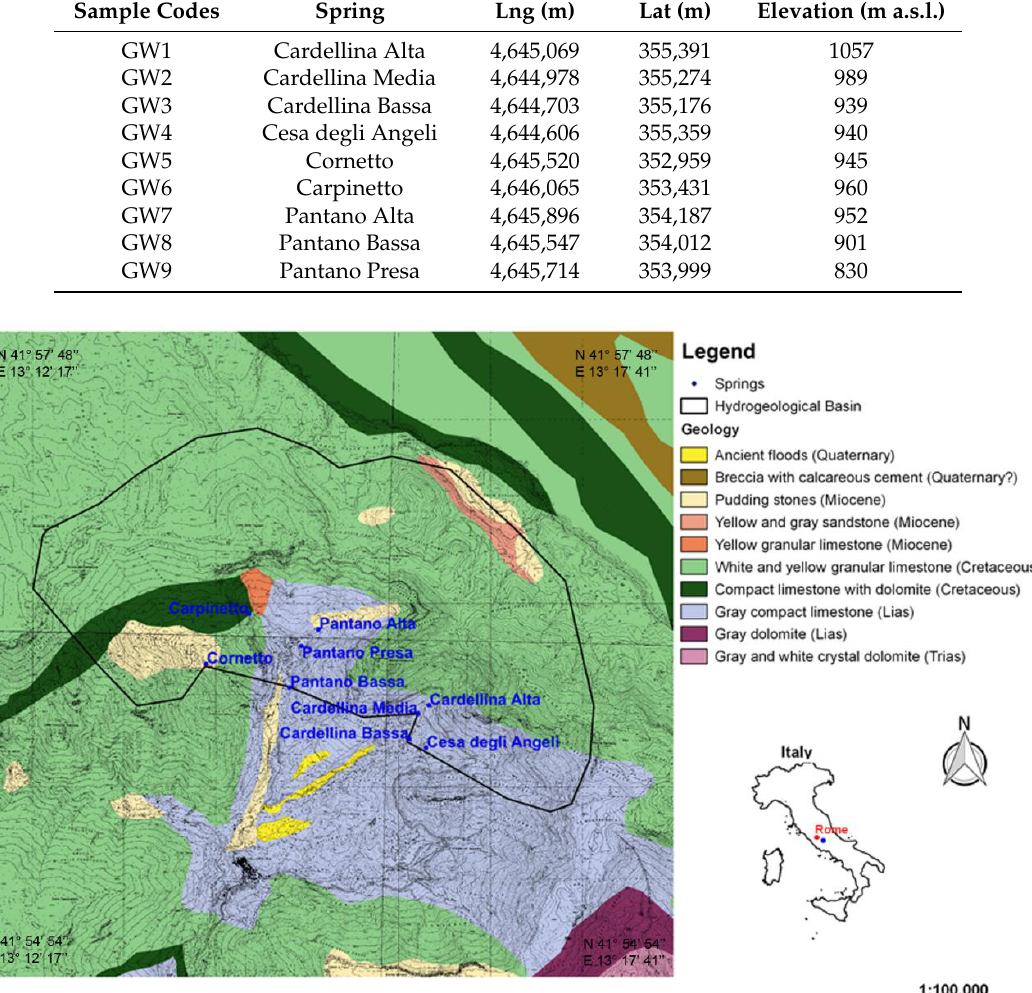
Figure 1. Geological map of the study area and location of karst basin.